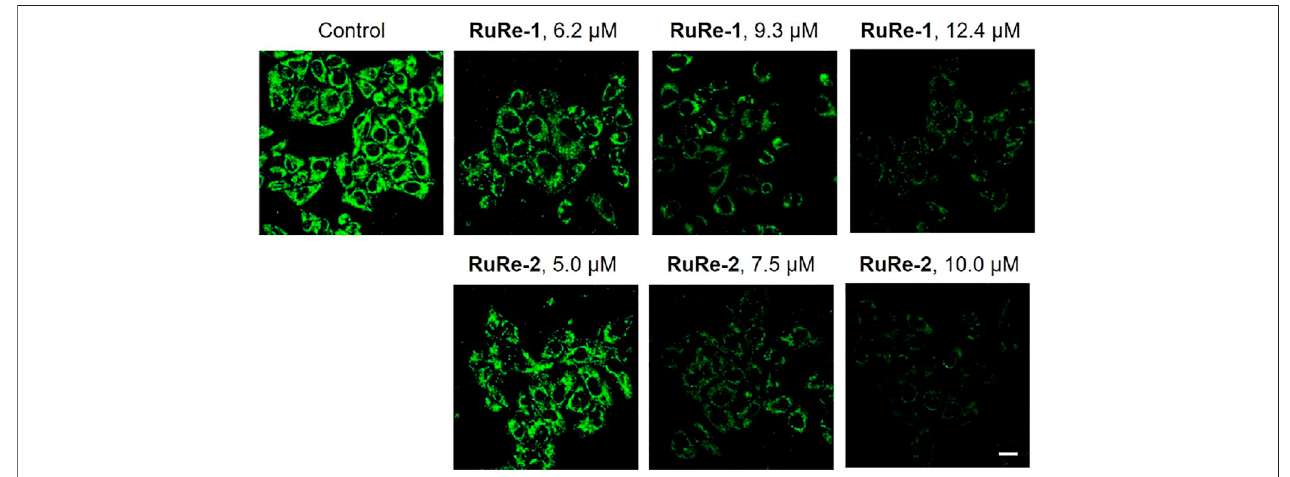
FIGURE 6 | RuRe-1 and RuRe-2 induced the loss of MMP analyzed by confocal microscopy with Rh123 staining ( λ ex = 488 nm, λ em = 530 ± 20 nm). The incubation time of the compounds was 6 h. Scale bar: 20 μ m.